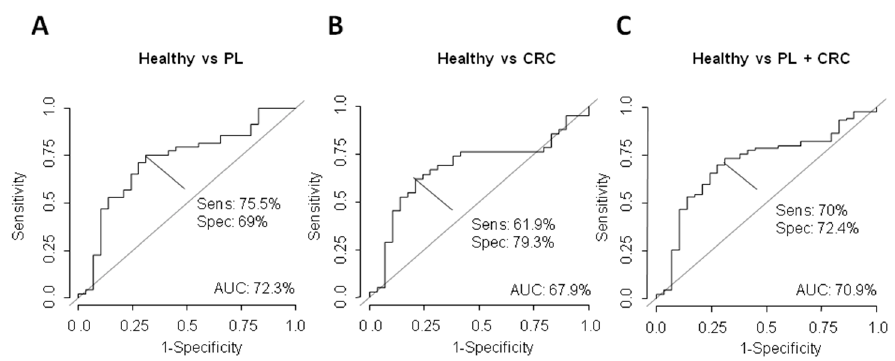
significance * p < 0.05; *** p < 0.001.